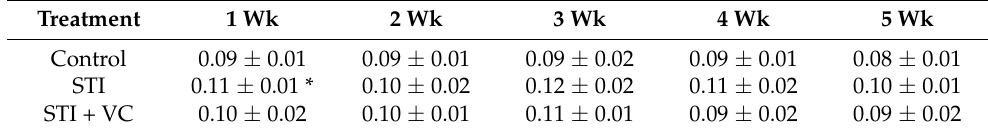
Table 3. Effect of different diets on the ratio of Pancreas/body weight in mice. Treatment 1